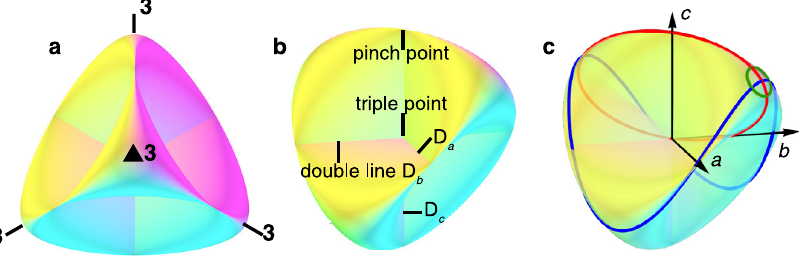
Fig. 1 Schematic diagram of a Roman surface. a , b Roman surface with four three-fold axes ( 3 ), one triple point, six pinch points, and three double lines (D a , D b , D c ). c Three geometrically different fundamental loops on a Roman surface. The red loop effectively winds twice to pass the two sides of the triple point as it rides on the Möbius strip being part of the Roman surface. The blue loop winds around the double line D c once to have W c = 1. The green loop does not enclose any double lines with zero W i ( i = a , b , c ). Both blue and green loops only wind once to close the